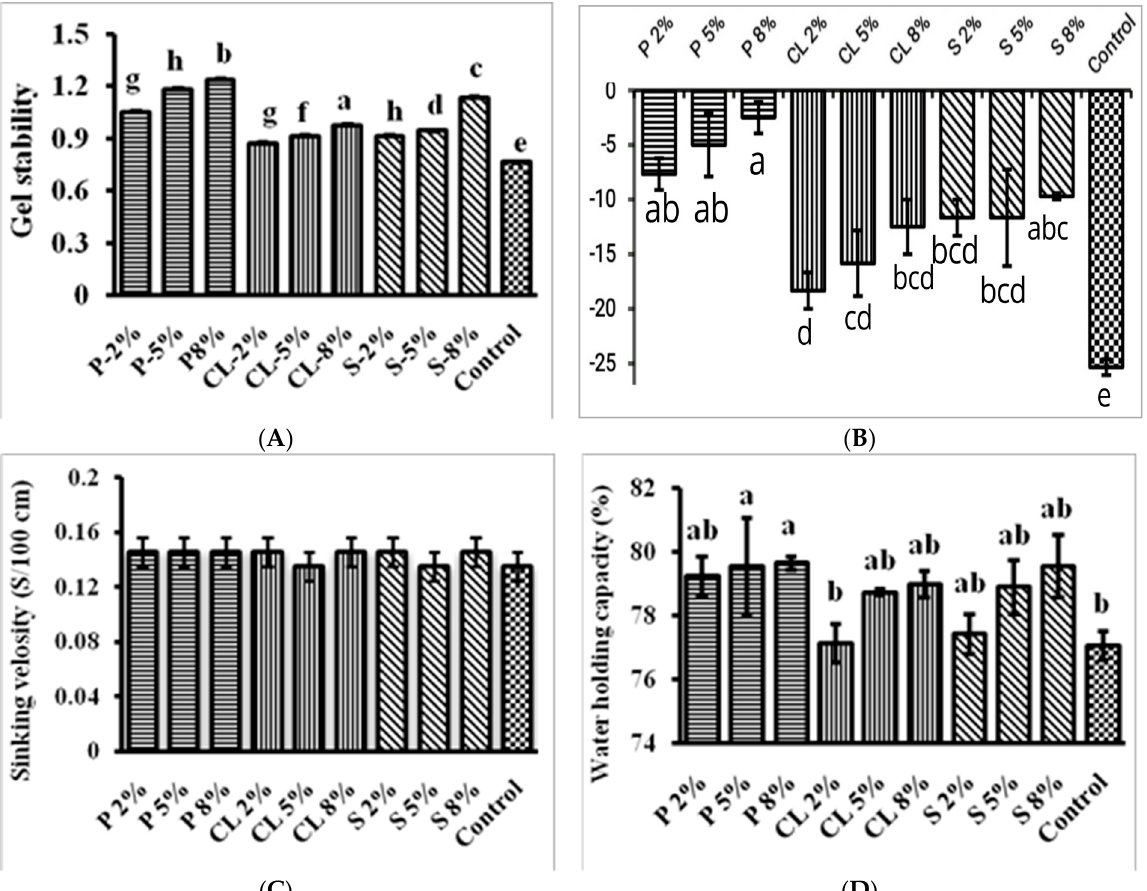
Figure 2. Physical properties of gel feed; ( A )gel stability; ( B )water stability; ( C )sinking velocity; ( D )water-holding capacity.*Data are represented as mean ± SE. Different superscripts indicate sta- ( D ) water-holding capacity. Data are represented as mean ± SE. Different letters indicate statistically tistically significant differences ( p <0.05) among the experimental groups. significant differences ( p < 0.05) among the experimental